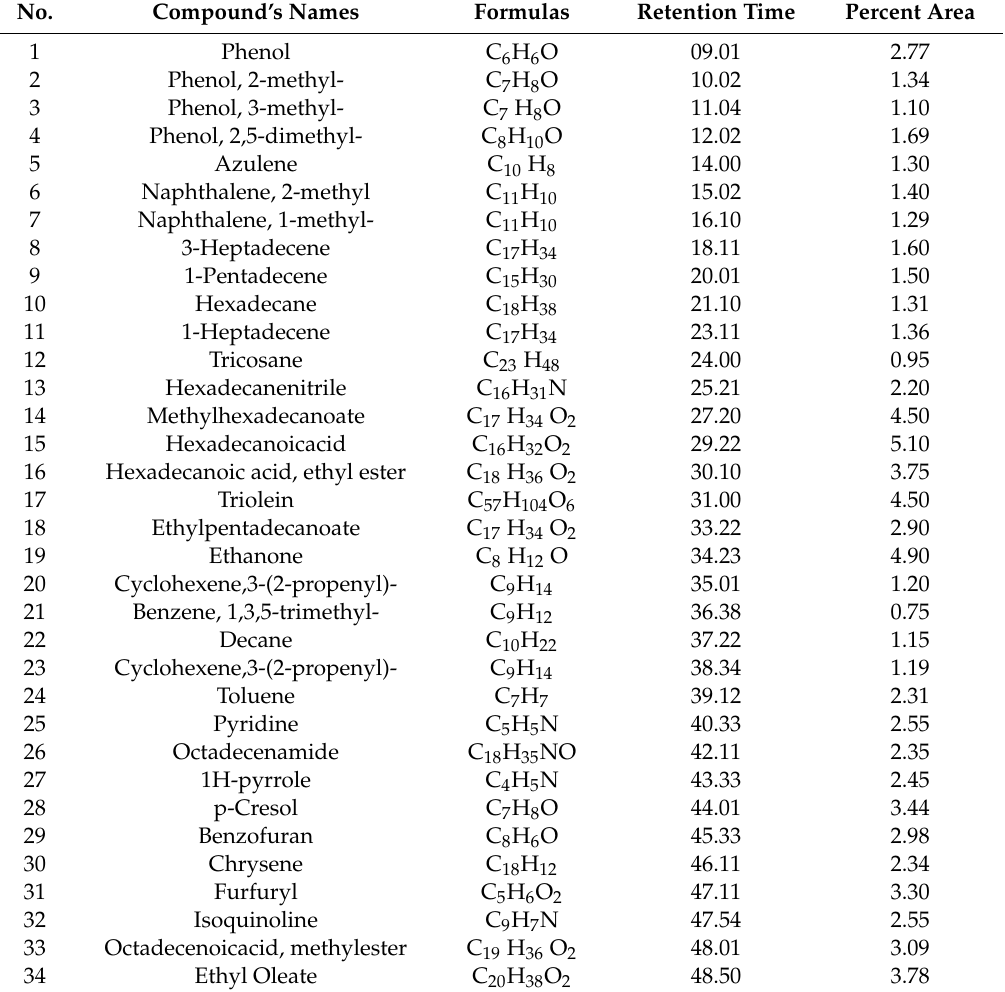
Table 2. Compounds identified in